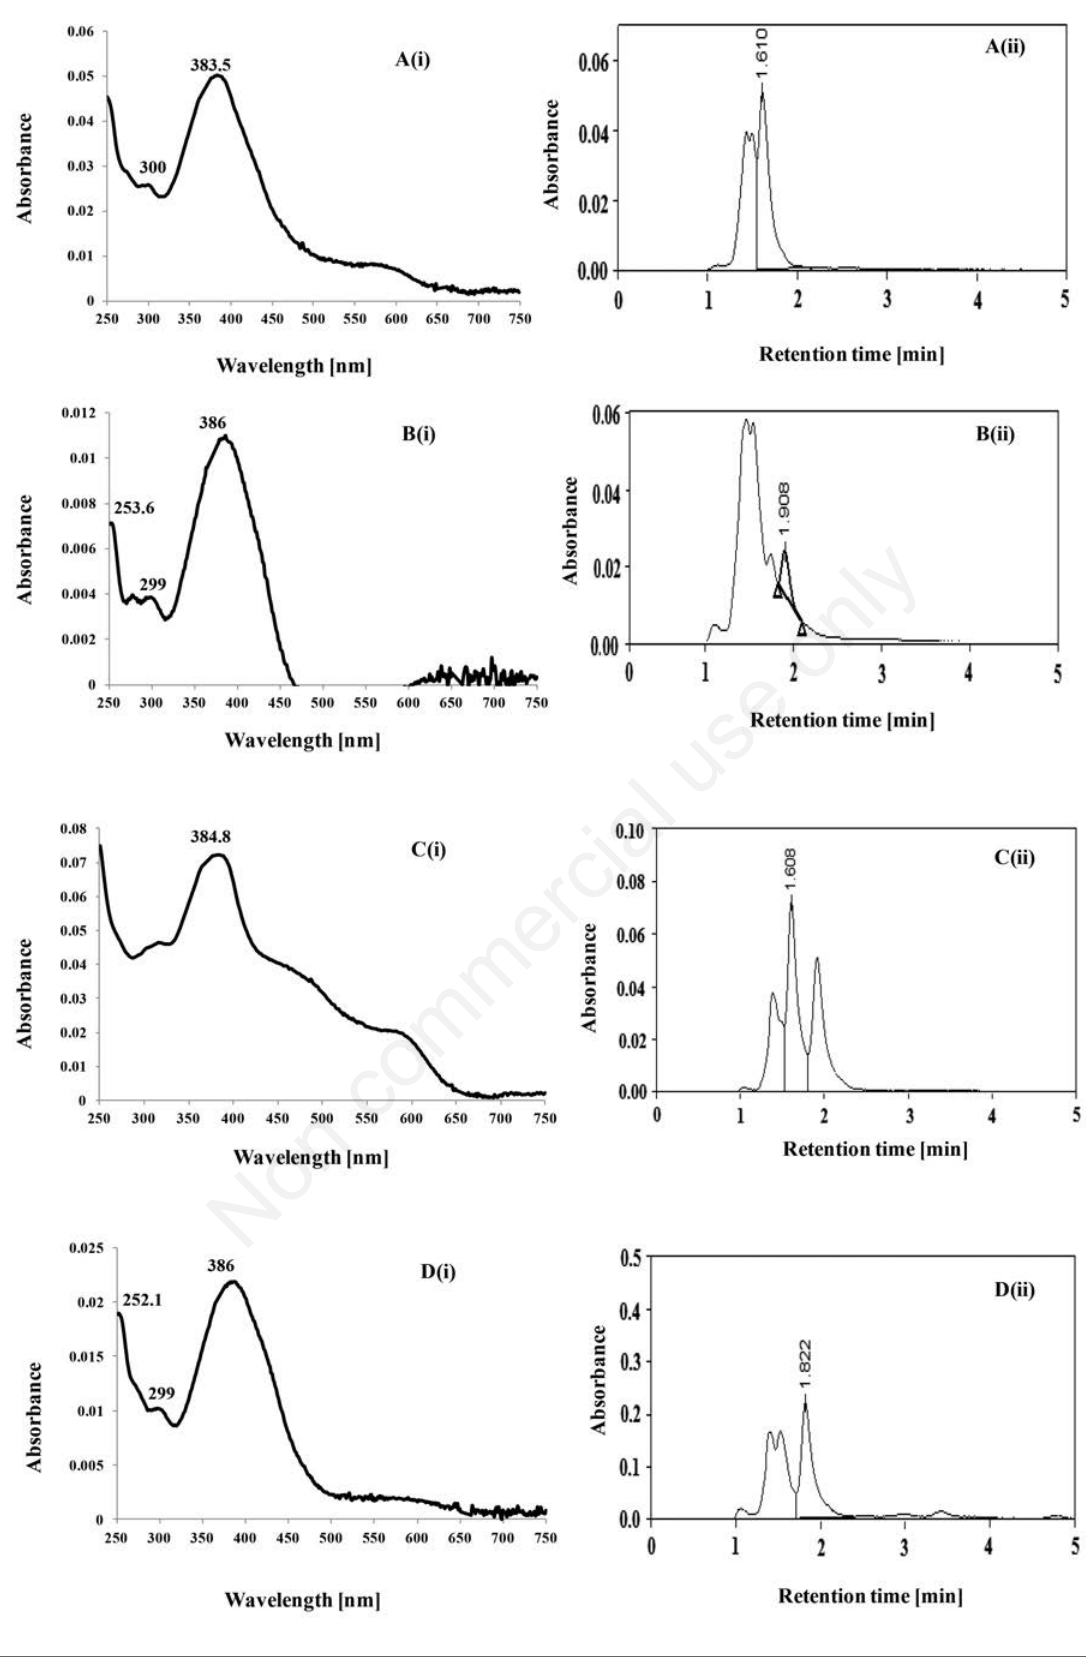
Figure 7. Absorption spectra of partially purified scytonemin (i) and its corresponding HPLC chromatograms (ii) from crust samples of (A) Bharatmata Temple, (B) Ramnagar Fort, (C) Vishwanath Temple, BHU and (D) Sanskrit University. All the experiments were repeated thrice with at least three